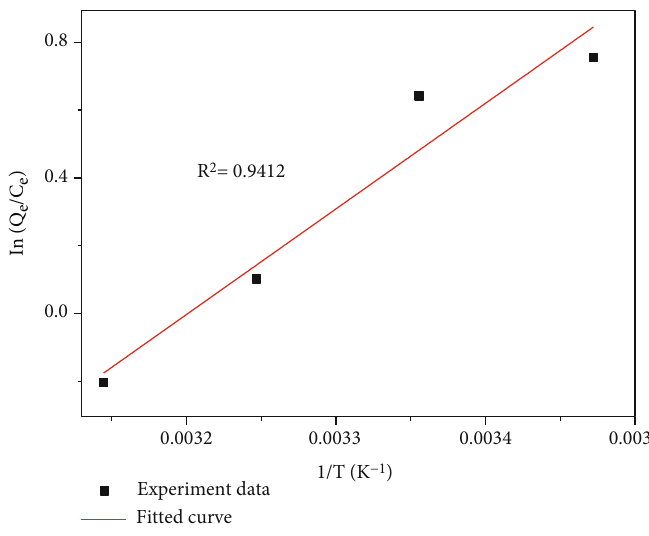
Figure 7: Thermodynamic adsorption for Cr (VI) removal on CSBT. Table 5: Constants of adsorption thermodynamics for Cr (VI) of CSBT.